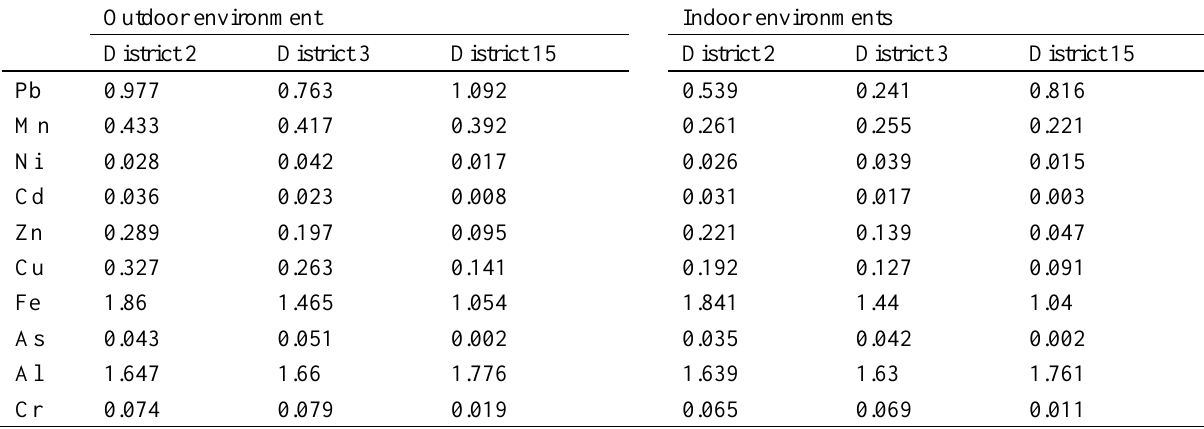
Table 2. Heavy metal concentrations (g/m 3 ) in six stations Outdoor